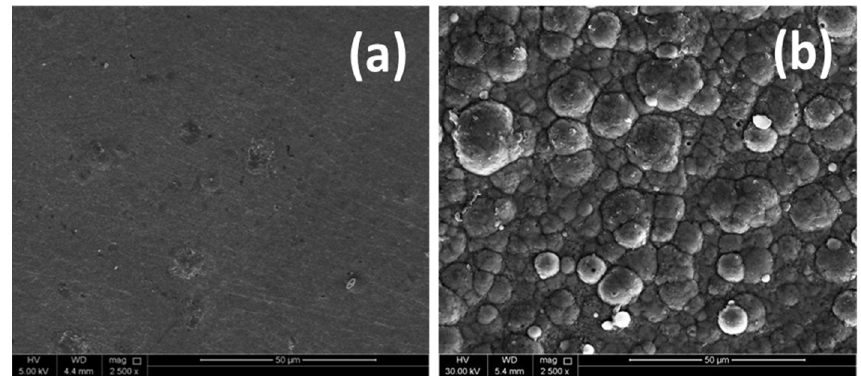
Figure 11. SEM micrographs of ( a ) NiP and ( b ) NiP-0.5TNPs composite coatings after heat treatment for 50 h in air.